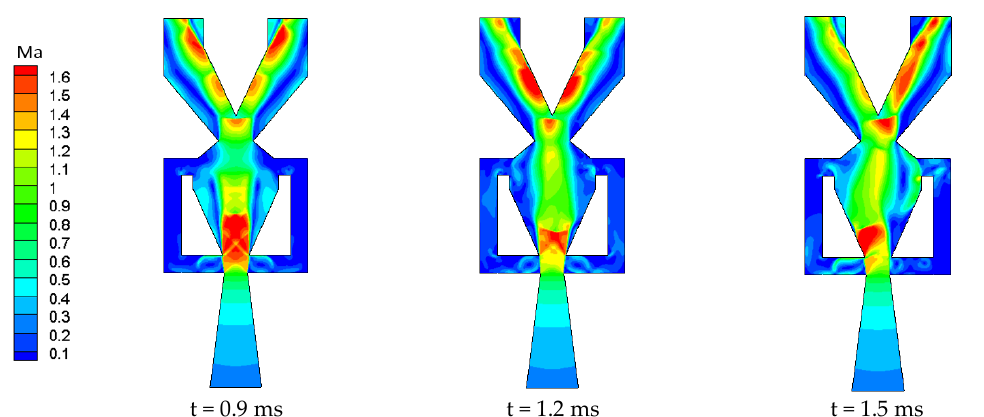
ff erent times in model M 8,